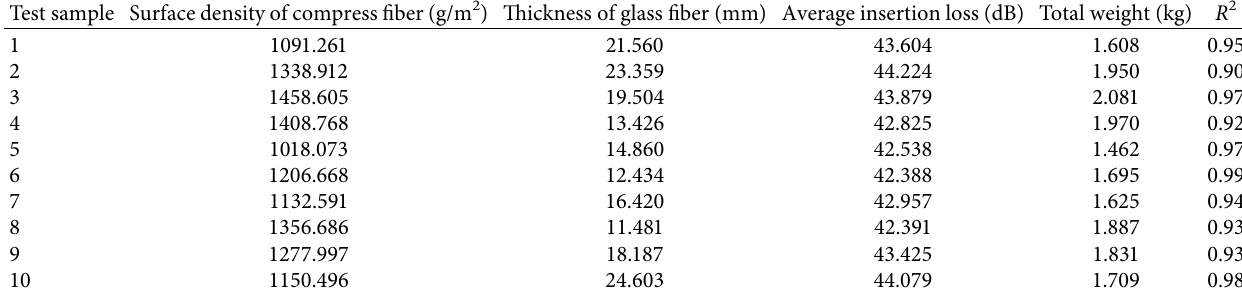
Table 9: Sample point used to test the accuracy of Kriging model.